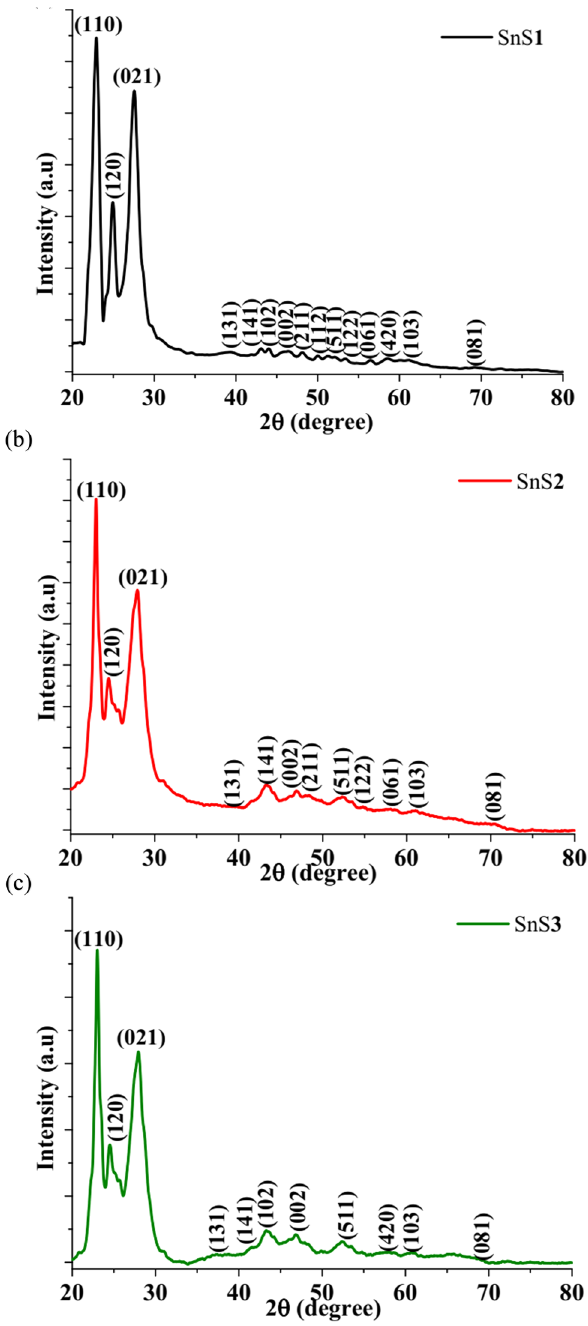
Figure 1: Powder X - ray di ff raction pattern of SnS1 ( a ) SnS2 ( b ) and SnS3 ( c )